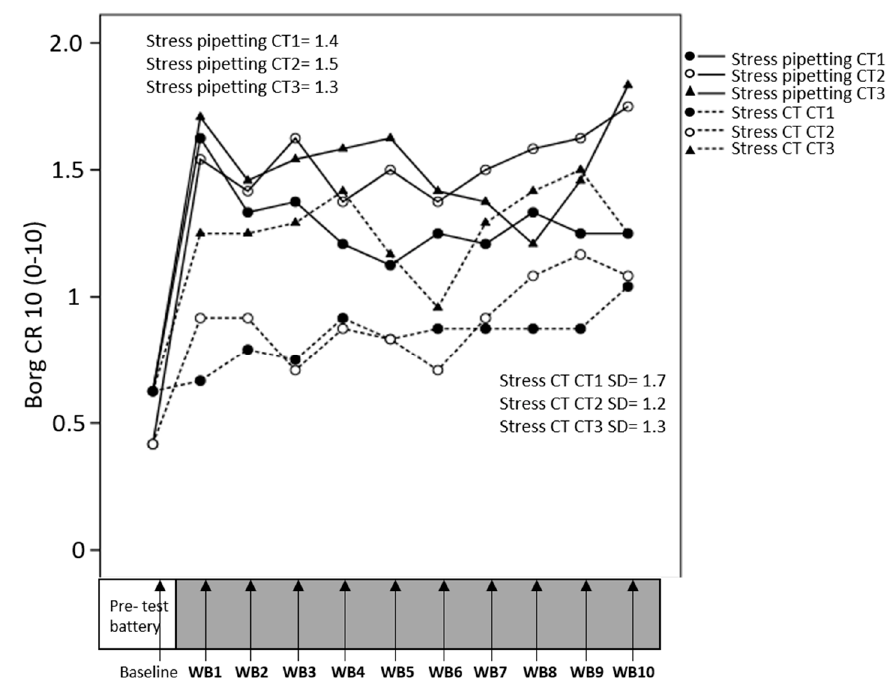
Figure 3. Development of perceived stress across consecutive work bouts (WB) of pipetting and cognitive task (CT). Each time point on the x-axis represents ratings of stress during the last minute of pipetting (full drawn lines) and just after each CT bout (dotted lines). Standard deviations for means across all participants and all time points.